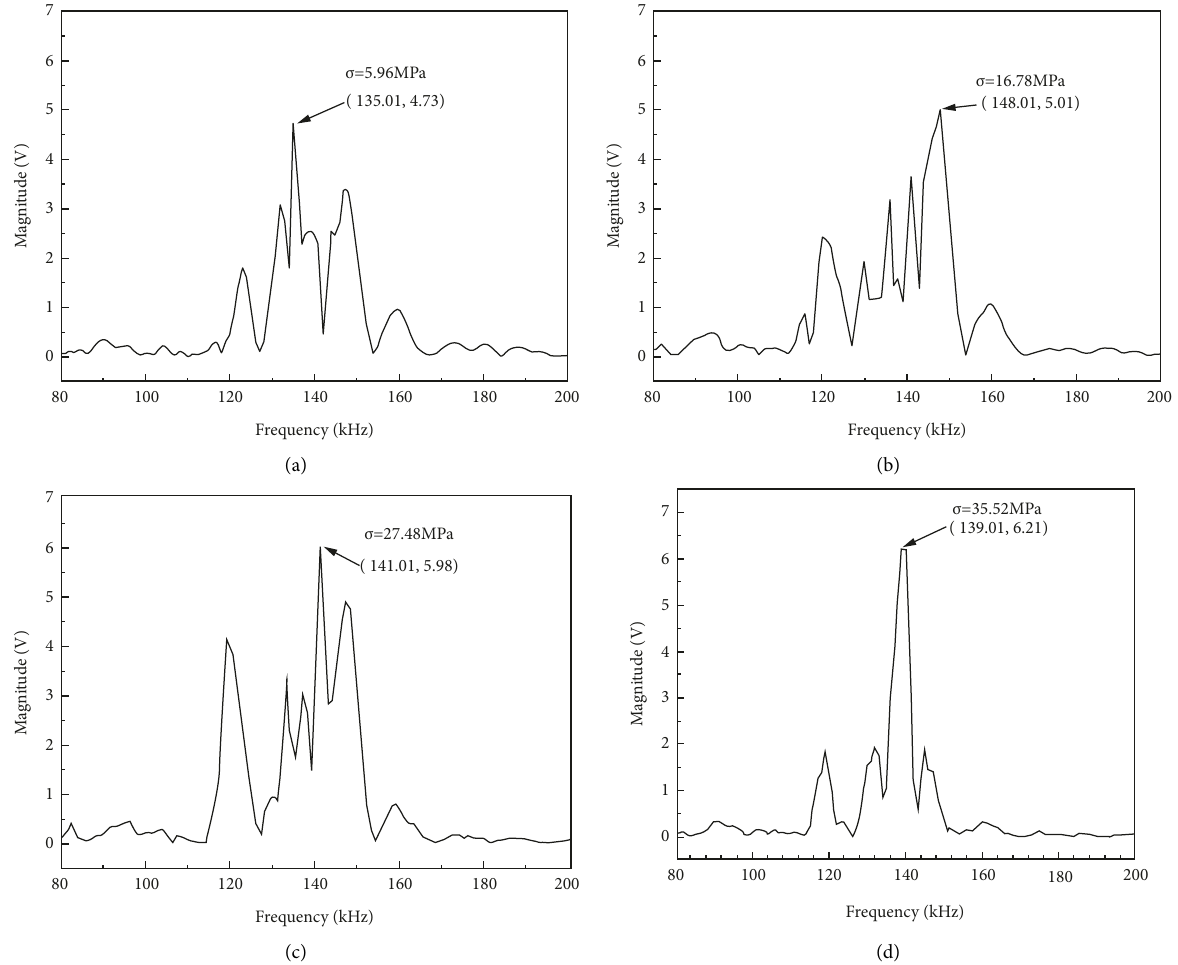
Figure 10: Two-dimensional spectrum of received ultrasonic signals at different stress levels. (a) 5.96 MPa. (b) σ (c) σ 27.48MPa. (d) σ (cid:30) (cid:30)